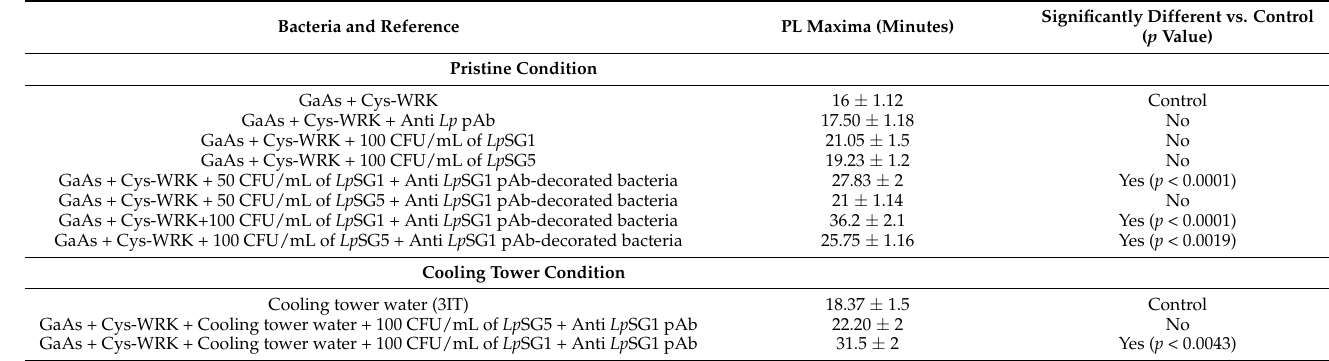
Figure 5. Normalized PL intensity of AMP-functionalized GaAs/AlGaAs DIP biochips (wafer D3422) exposed to bacteria in 1 × PBS. The open circle (R1) and semicircle (R2) plots represent reference without exposing to bacteria. The red full circle and green square plots represent the exposure to 100 CFU/mL of L. pneumophila SG1 and SG5, respectively. The black open square and cyan semisquare plots represent the exposure to 100 CFU/mL of pAb-decorated L. pneumophila SG1 and SG5, respectively. Table 2. PL maxima obtained for the reference (PBS) run and after the exposure of L. pneumophila (all experiments repeated for at least 3